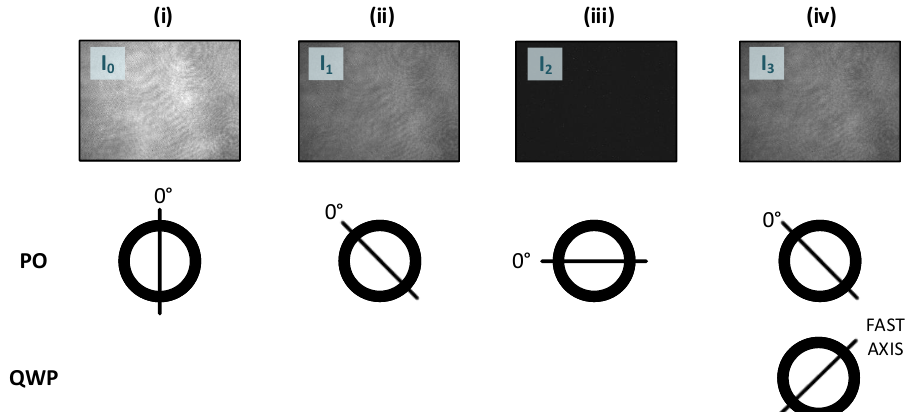
Figure 2. The generation of the Stokes parameters S 0 , S 1 , S 2 , and S 3 to determine the degree of polarization (DOP) (with the adjustments of the polarizer (PO) and the quarter-wave plate (QWP) for each measurement): ( i ) capture of the intensity I 0 (first measurement); ( ii ) capture of the intensity I 1 (second measurement); ( iii ) capture of the intensity I 2 (third measurement); ( iv ) capture of the intensity I 3 (fourth measurement) (measurement pictures of a surface with the RMS roughness S q = 31nm (see Sample 2 in Table 1) at a wavelength of λ =